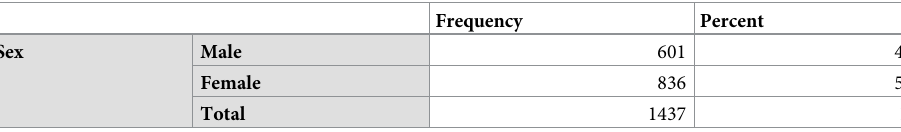
Table 1. Distribution of sex among the participating